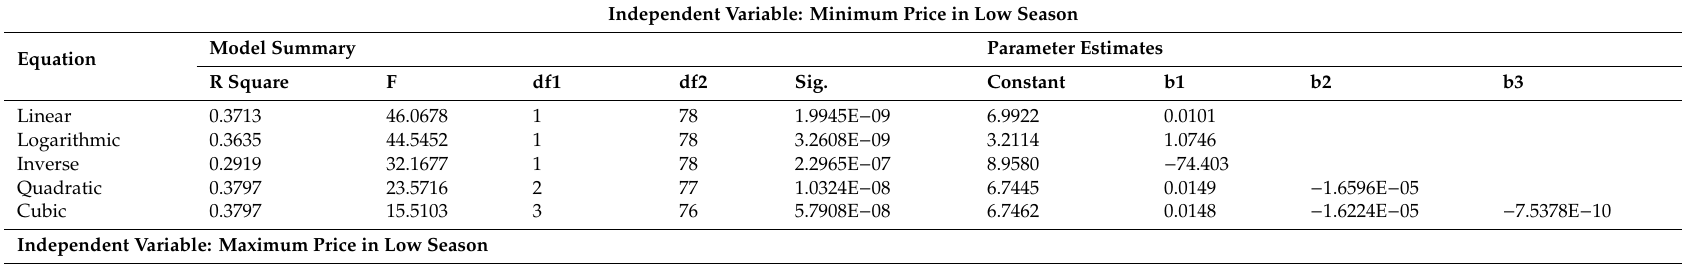
Table 9. Model summary and parameter estimates of regression analysis in Tenerife destination with Q as dependent